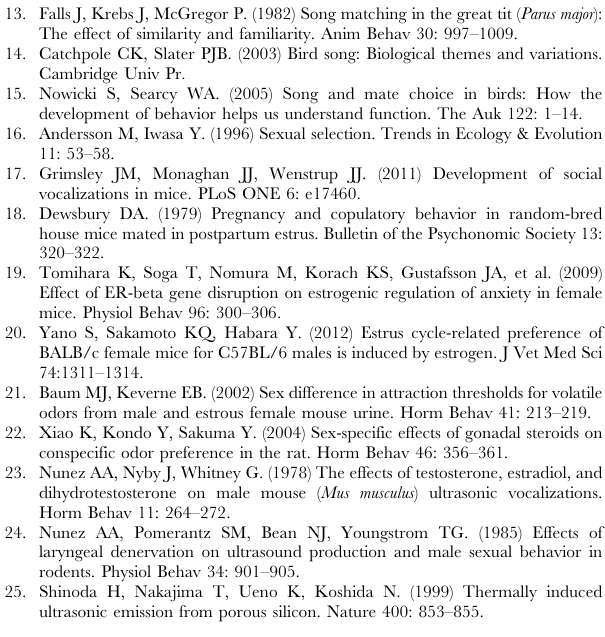
Figure S1 Parametric analysis of song profiles. ( a ) Mean percentage composition for each syllable category in the 4 strains of mice. Percentages were the average probability calculated in each subject. ( b ) Mean peak frequency, ( c ) inter-syllable interval, and ( d ) duration of syllables in songs of each mouse strain. Different letters above bars represent significant differences at a = 0.05. Figure S2 In the absence of male odor stimuli, or when in pro-estrous or estrus, females did not show a preference for songs of males of a different strain. ( a ) Duration of time searching for songs during pro-estrus in B6 ( n = 7) and BALB ( n =6) females exposed to male odor before testing. ( b ) Duration of time searching during estrus in B6 ( n = 6) and BALB ( n = 6) females exposed to male odor before testing. ( c ) Duration of time searching during pro-estrus in B6 ( n = 5) and BALB ( n = 5) females in the absence of male odor before testing. ( d ) Duration of time searching during estrus in B6 ( n = 6) and BALB ( n = 6) females in the absence of male odor before testing. There were no significant differences among these conditions.